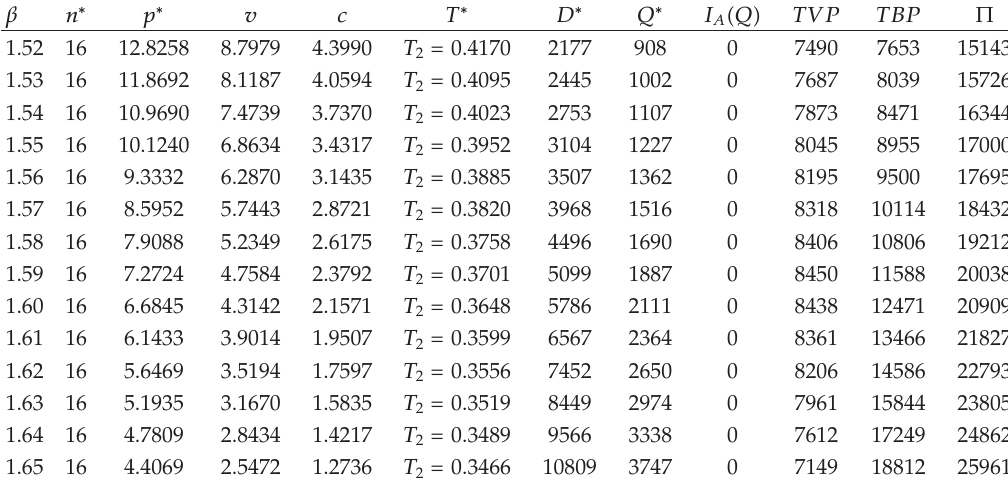
Table 4: Computation results for various values of β (cid:3) γ (cid:8) 1.5 (cid:4)